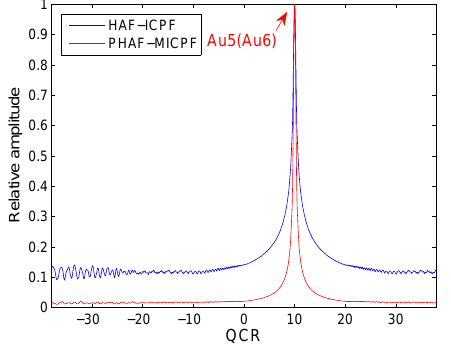
Figure 6. Cross-term suppression of